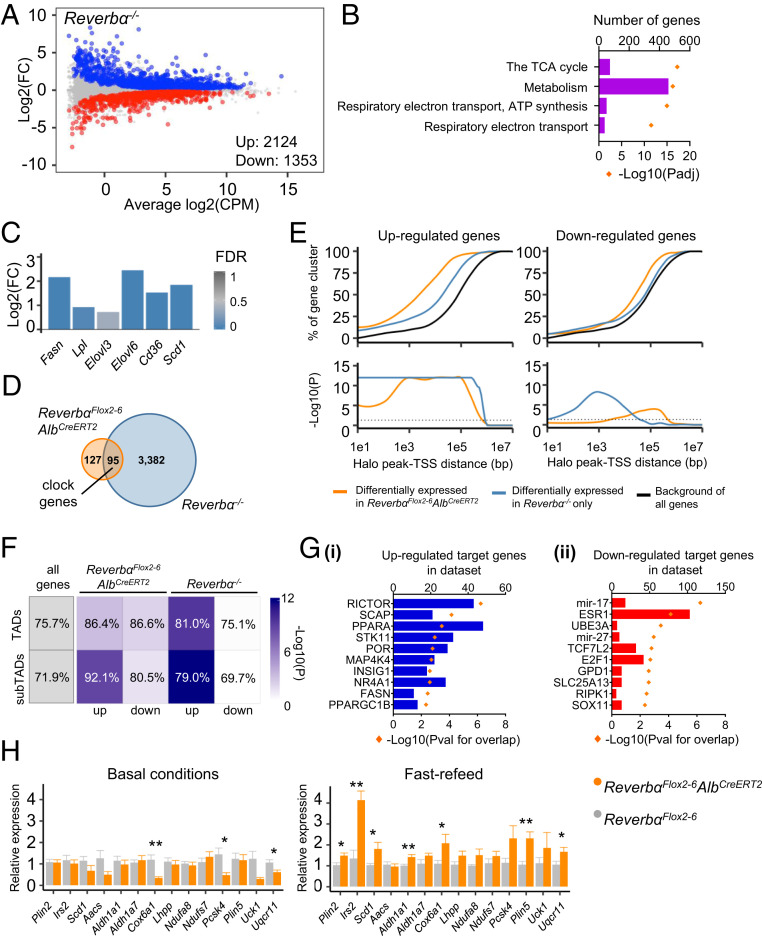
The broader repressive effects of REVERBα become evident under conditions of metabolic perturbation. (A) MD plot of liver RNA-seq from Reverbα−/− male mice (relative to littermate controls); genes with significant differential expression (FDR < 0.05) highlighted in color (up-regulated in blue, down-regulated in red). (B) Reactome pathway analysis of significantly DE genes shows enrichment of metabolic pathways. Four pathways with lowest Padj are shown. Full results are in SI Appendix, Table S7. (C) Lipid metabolism genes are differentially expressed in the livers of Reverbα−/− mice compared to controls (fold change [FC] and FDR of selected clock and lipid metabolism genes from A). (D) Overlap of significantly DE genes in each mouse model. (E) Proximity of DE genes to HaloREVERBα peaks in both liver-specific and global deletion of REVERBα. (E, Top) Proportion of each gene set lying within a given distance of peaks. (E, Bottom) Significance of the enrichment of each gene set compared to all genes in the genome at each distance. (F) Cistrome-transcriptome associations respect TAD/subTAD boundaries. Table lists percentage of DE genes from each RNA-seq cluster which are found within the same TAD/subTAD as HaloREVERBα sites. Percentage of all genes is shown for comparison. Depth of shading indicates significance of enrichment (compared to all genes). (G) IPA identifies regulators putatively upstream of genes which are (i) only up-regulated (derepressed) or (ii) only down-regulated in Reverbα−/− livers, and which are within 100 kbp of HaloREVERBα sites. (H) Mistimed feeding causes significant increase in expression in ReverbαFlox2-6AlbCreERT2 liver (Right) at HaloREVERBα-associated genes, which are not derepressed under basal conditions (Left). *P < 0.05, **P < 0.01 Welch’s t tests, n = 8 to 14 per group.